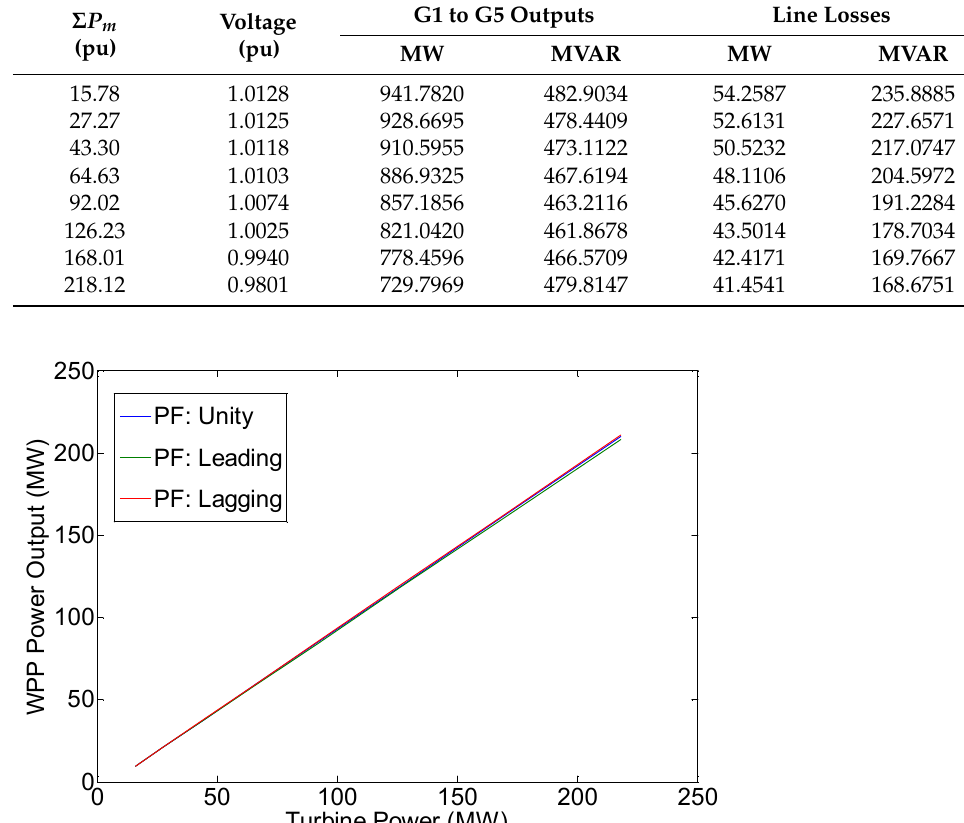
Figure 7. Variation of WRIG rotor power ( P R ). Figure 8. Variation of WRIG active power loss ( P LOSS ).